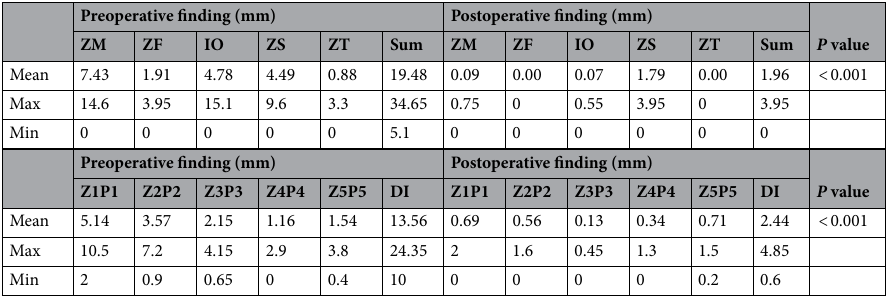
Table 2. Preoperative and postoperative measurements for the zygoma. ZF Zygomaticofrontal, IO Inferior orbital rim, ZS Zygomaticosphenoidal, ZM Zygomaticomaxillary, ZT Zygomaticotemporal, SD standard deviation, Z point on zygoma surface of CT image, P point on surface of zygoma object of presurgical planning, DI deviation index, Max maximum, Min